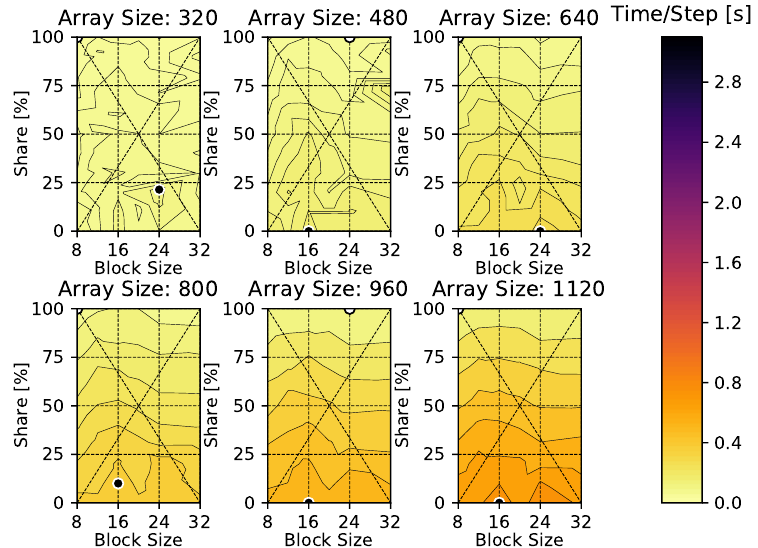
Figure A1. Heat equation time per timestep performance using Swept solver with Intel E5-2698v4 CPUs and Tesla V100-DGXS-32GB GPUs.